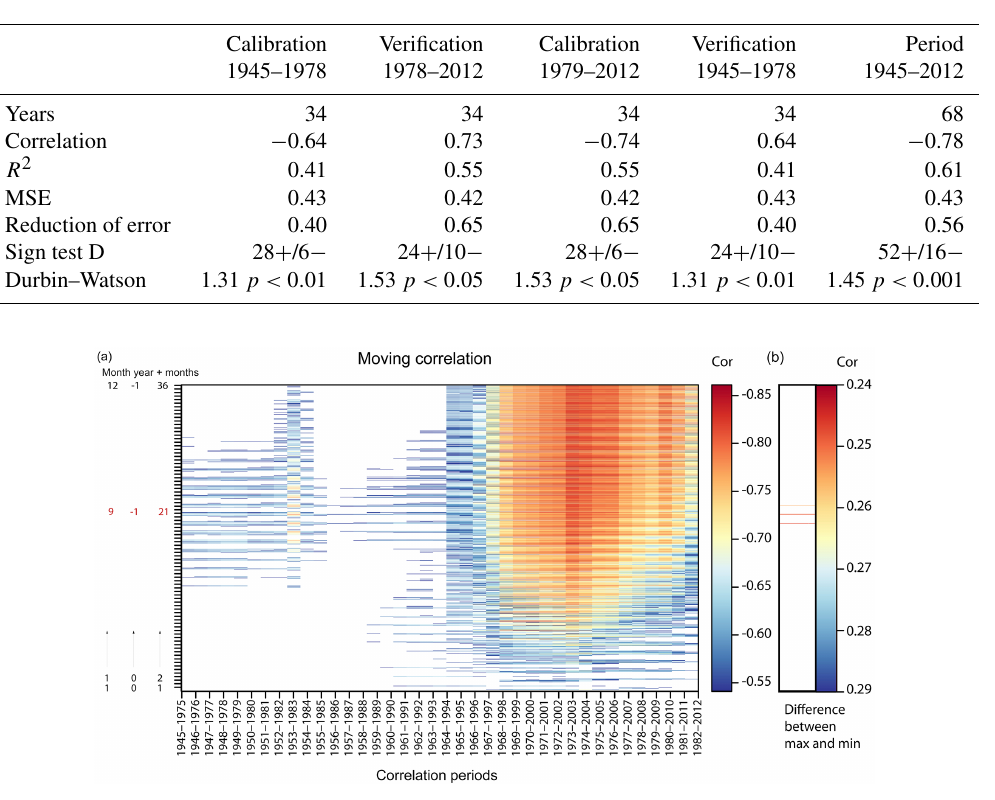
Figure 7. (a) Thirty-year moving correlation from 1945 to 2012 between the monthly mean of daily maximum temperature, from January of the current year (1, 0, 1) to December of the previous year (12, − 1, 36) with a cumulative monthly mean from 1 to 36 months and the BasPois chronology. Red numbers indicate the chosen climatological parameter: 9, September, − 1, previous year, 21, months used for the cumulative monthly mean. (b) The four best parameters are represented. The reddish line indicates the least difference between the maximum and minimum correlation in the correlation